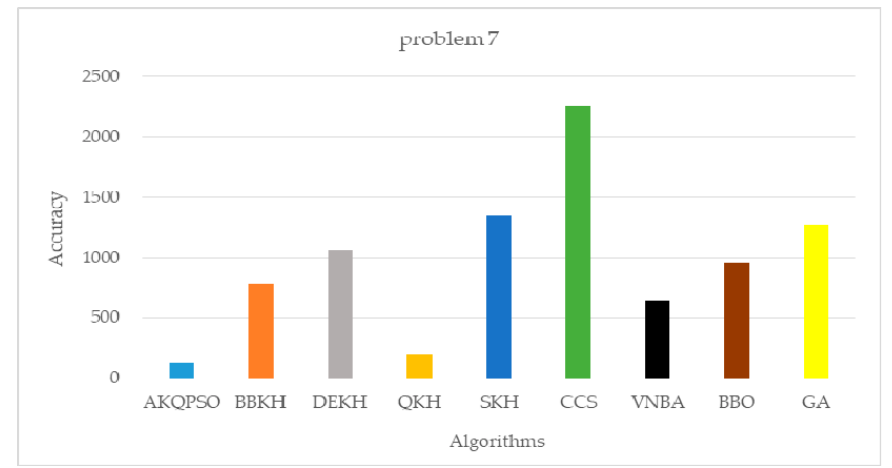
Figure 9. Accuracy of AKQPSO and other algorithms on problem 7: modified Schwefel’s function.